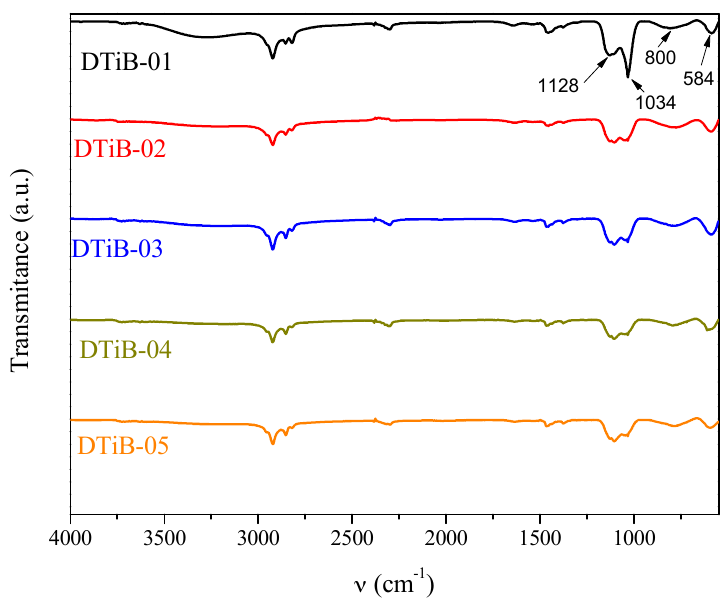
Figure 5. Fourier-transform infrared spectroscopy (FT-IR) spectra for all the CD-aTiO 2 synthetized and used in this work.